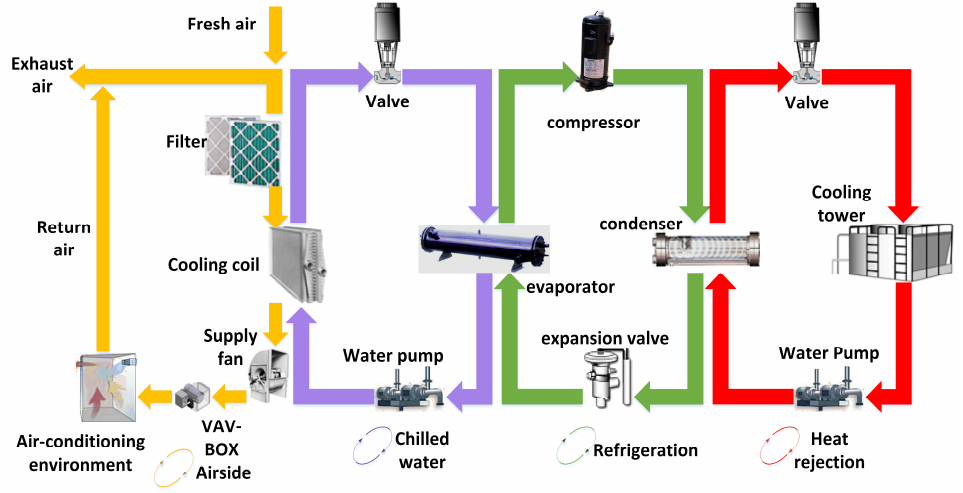
Figure 6. Four circles of HVAC systems.